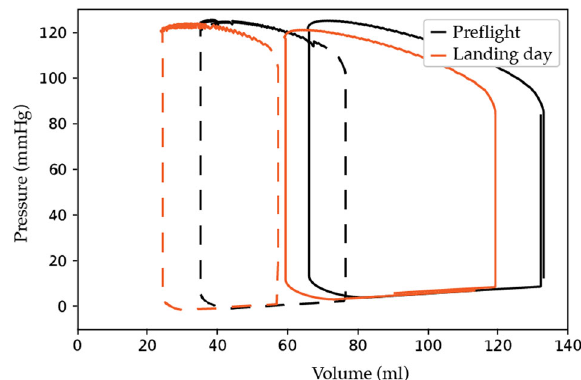
Fig. 1 Pressure-volume loop: effect of stand test on the left ventricle before and after a short duration space fl ight. Pressure- volume loop of the left ventricle pre- fl ight (black) and on landing day after a short duration space fl ight (orange), with solid lines representing the supine position and the dashed lines after standing